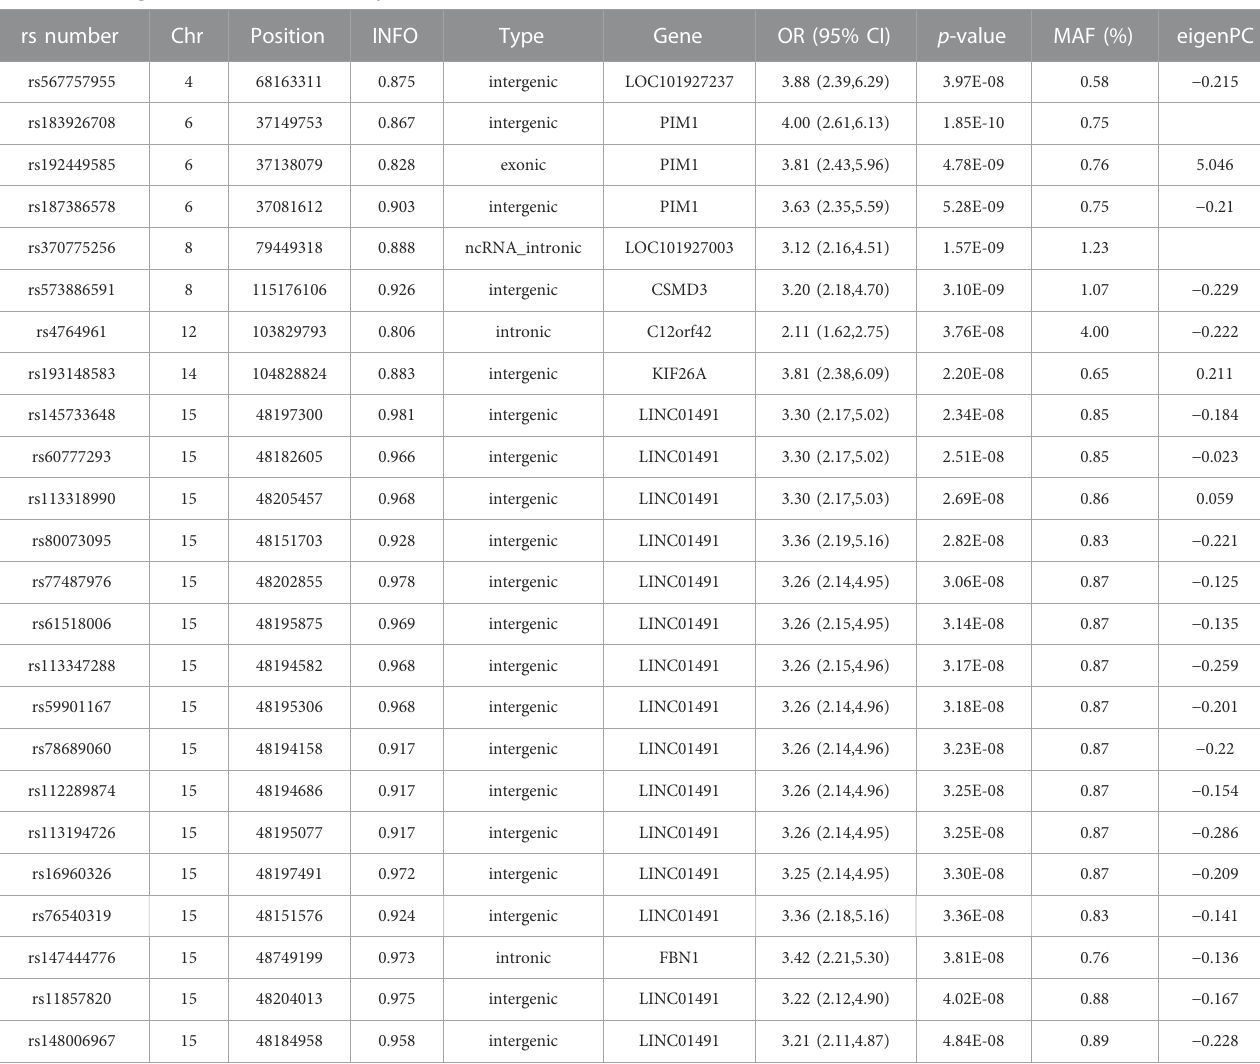
TABLE 1 Detailed genome wide association study